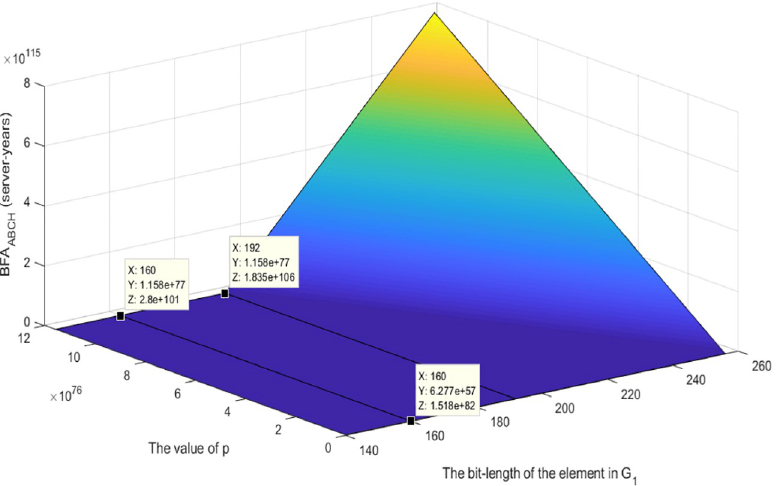
Fig 9. Cost of BFA AECH vs. the bit-lengths of the element in G 1 and p .